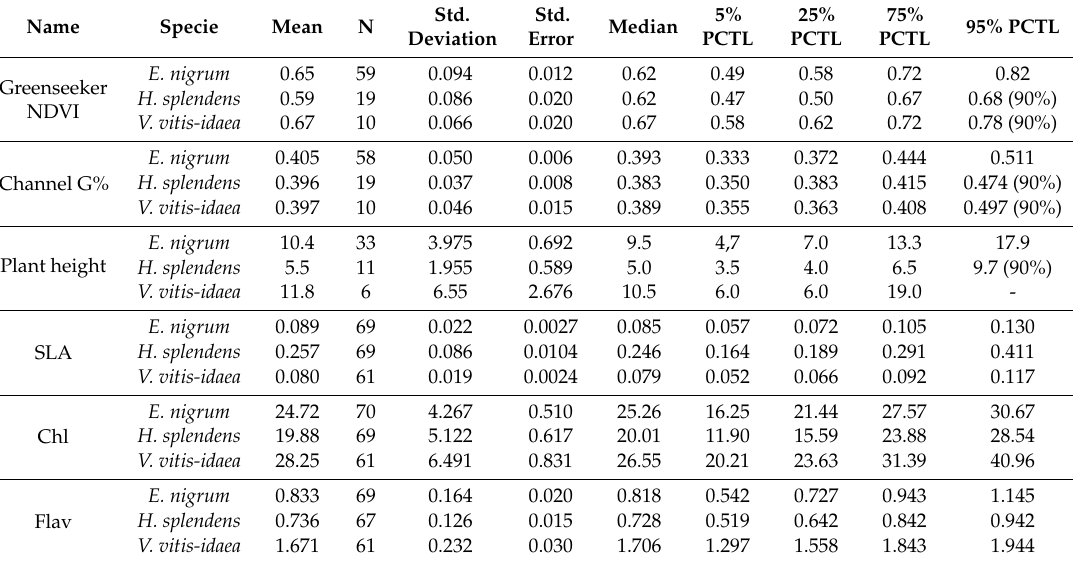
Table 5. Descriptive statistics of the monitored plant traits on species level.